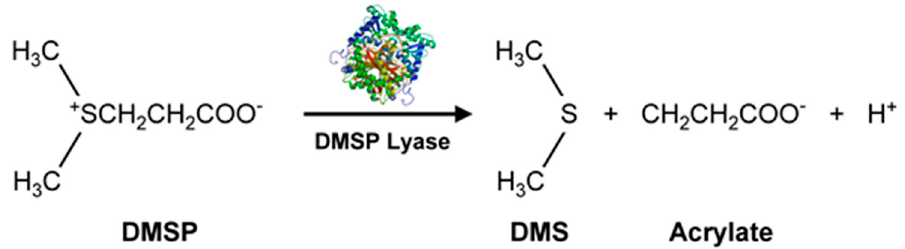
Figure 5. DMSP reaction liberating the volatile DMS product. A computer representation of the molecular level ribbon structure of DMSP lyase enzyme is shown above the reaction arrow.